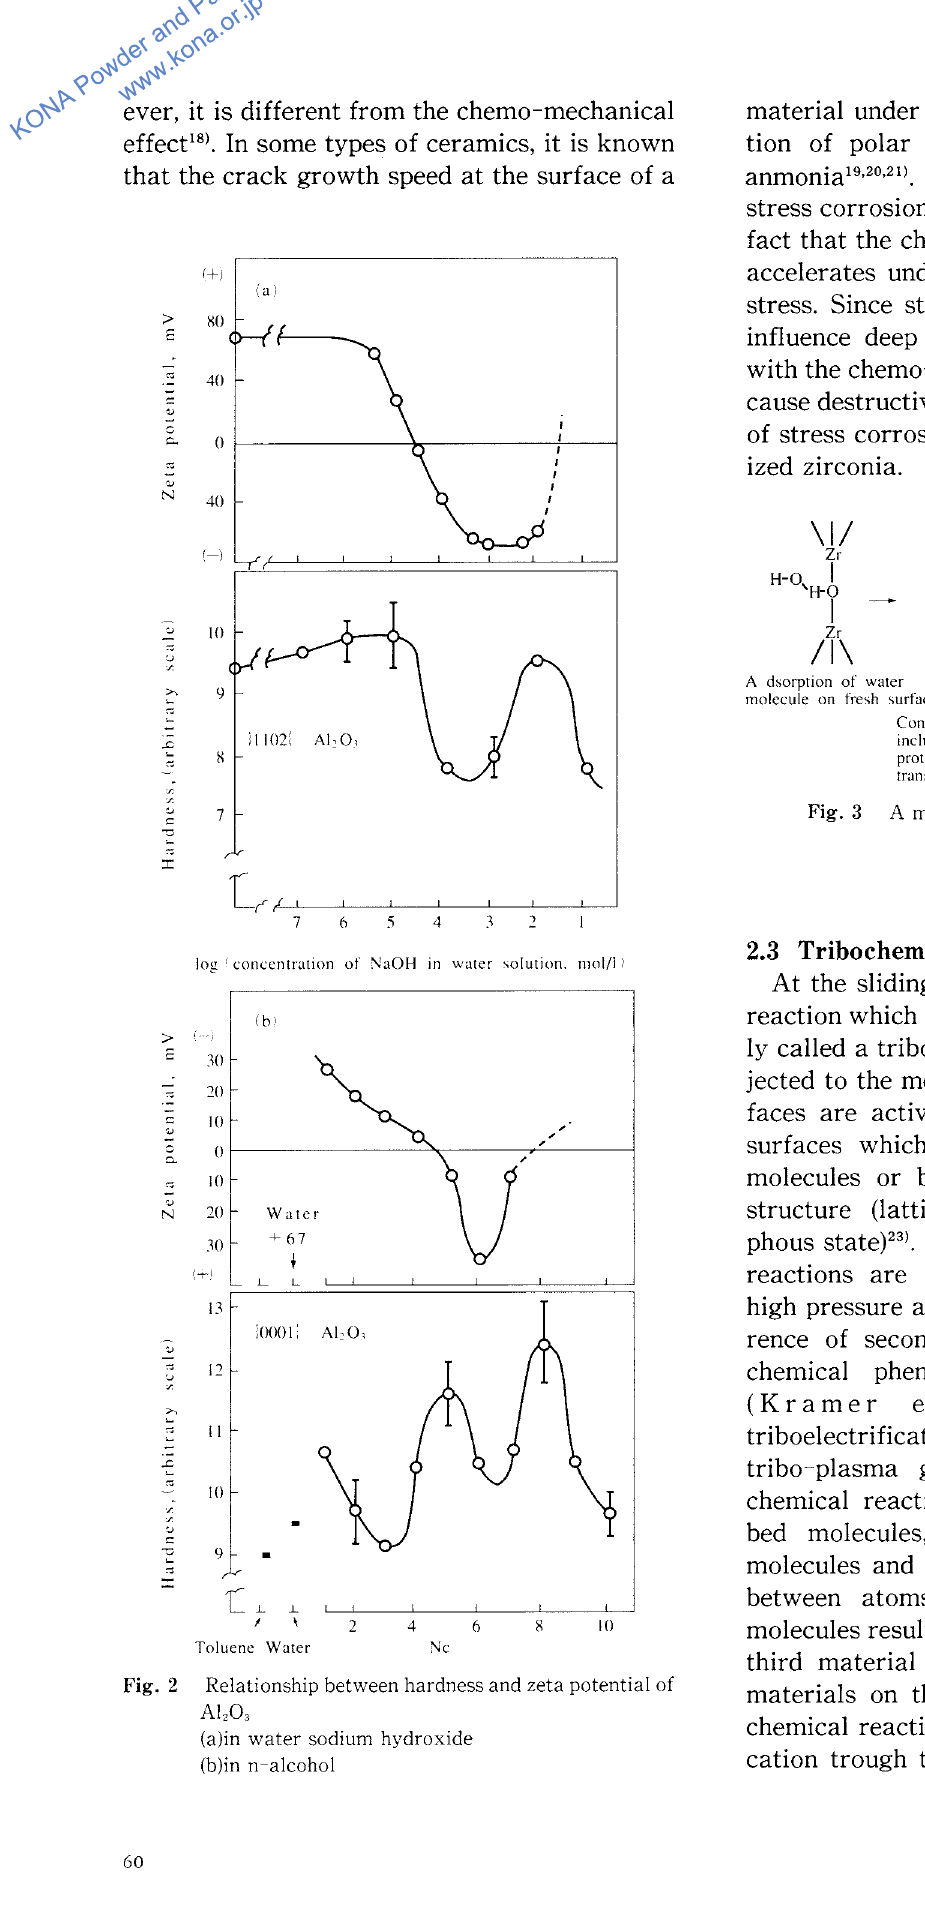
Fig. 2 Relationship between hardness and zeta potential of